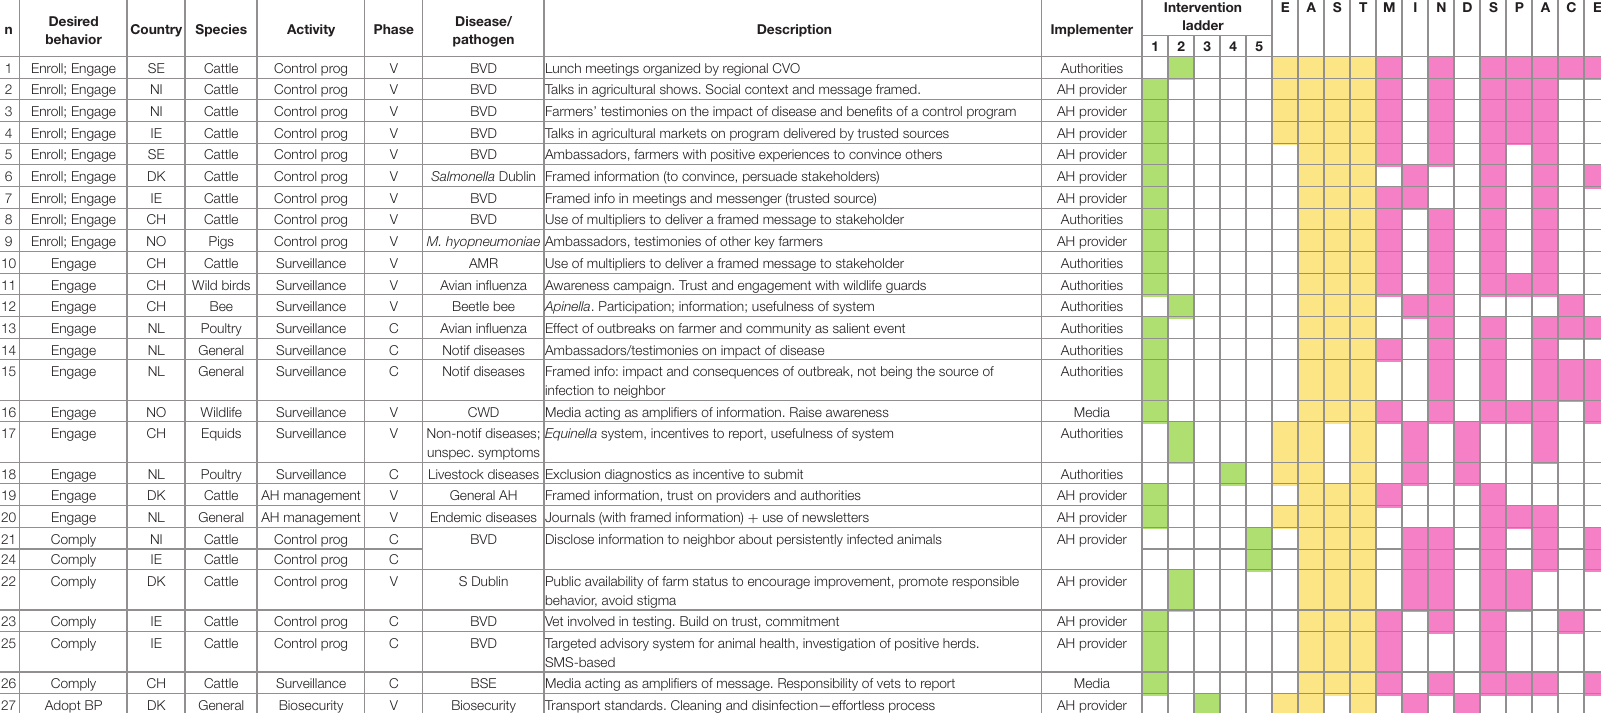
TABLE 4 | Characteristics of the selected strategies showing design features compatible with three or more EAST attributes. n Desired